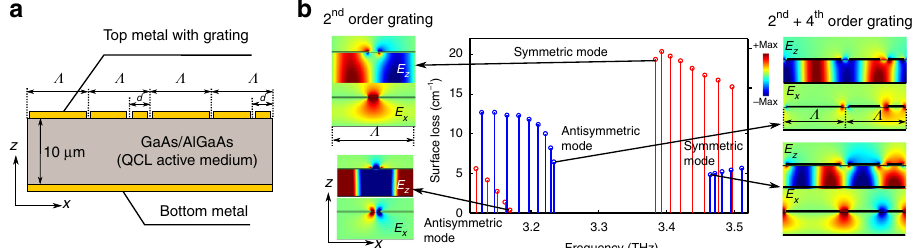
Fig. 2 Comparison of hybrid DFB and second-order DFB for terahertz QCLs. a Illustration of a metallic cavity for terahertz QCLs in which slits are opened in the top metal cladding to implement a periodic grating 18 . A fourth-order grating is superimposed at an offset of length d to the original second-order grating with periodicity Λ to realize a hybrid grating structure as in Fig. 1c. b Mode-spectrum for a 1.4 mm long and in fi nitely wide cavity with DFB gratings ( Λ = 27 μ m, slit-width ~3 μ m) computed with fi nite-element modeling method. Radiative surface-losses for various resonant modes for cavity with second-order gratings are plotted in red (thin-lines), and that for cavity with hybrid gratings ( d / Λ = 3/8) in blue (thick-lines). The insets show electric fi eld pro fi les for lower and upper band-edge modes respectively, of the photonic bandstructure for each type of gratings (the color-bar shown in this fi gure applies to all the plots of electric fi eld pro fi les). The radiative loss is effectively determined by the amplitude and phase of the in-plane electric fi eld ( E x ) in the slits ( E x ) fi eld) 18 . In comparison, the cavity with the hybrid second- the active medium that lowers the effective propagation index n eff order and fourth-order gratings greatly enhances the surface-loss of the guided waves. for the antisymmetric lower band-edge mode due to additional For the symmetric mode excited in the case of hybrid DFB with radiation from the slit corresponding to the fourth-order super- posed grating. The loss for the symmetric upper band-edge mode is reduced from that of the second-order DFB structure. For the simulated case of d / Λ in Fig. 2, the upper band-edge mode is of lower loss for the hybrid DFB grating, and will be excited in a lasing cavity. More importantly, the surface loss of the excited The hybrid DFB grating offers fl exibility in design by simply mode in laser cavity with hybrid DFB can be enhanced by an altering the offset d at which the fourth-order grating is order of magnitude from that of the second-order DFB cavity. It implemented as shown in the schematic in Fig. 2a. The relative may be noted that bandgap of the hybrid DFB cavity has a red- radiative losses of the two band-edge modes could be modulated shift of ~0.08 THz in the shown simulation, which is due to the by adjusting d / Λ , which is useful to design for selective excitation fact that a larger fraction of evanescent fi eld propagates outside